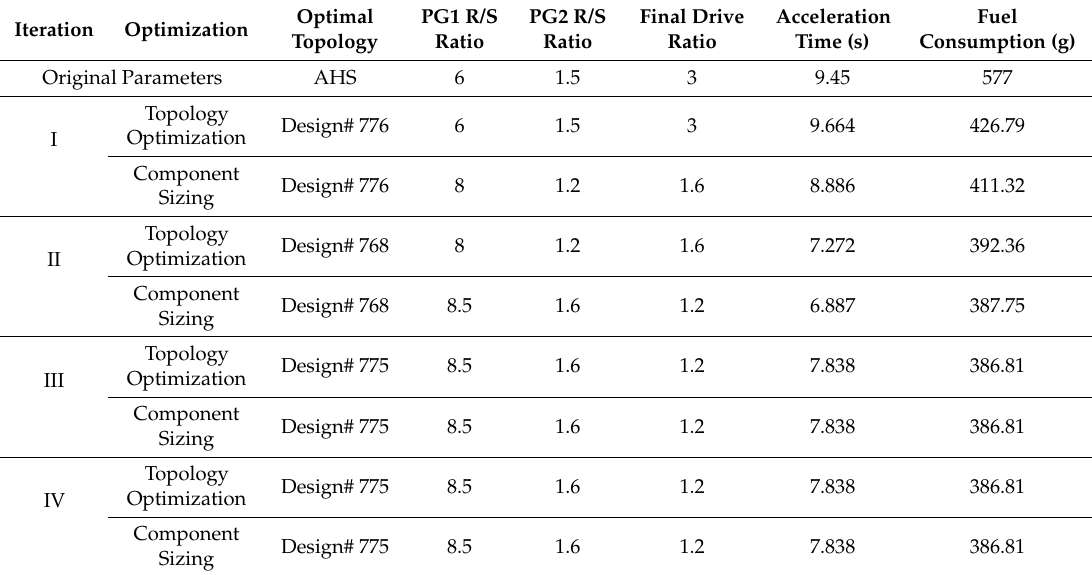
Table 3. Optimal results of each iteration for initial point (FR = 6, PG1 = 1.5, PG2 = 3).